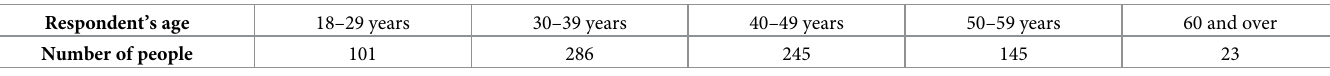
Table 2. Age of the respondents (N = 800).